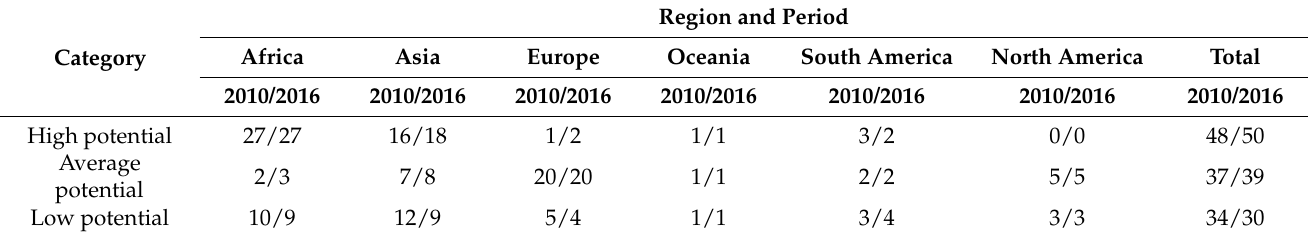
Table 3. Distribution of arable land investment potential in countries with the “belt and road initiative” in 2010 and 2016.